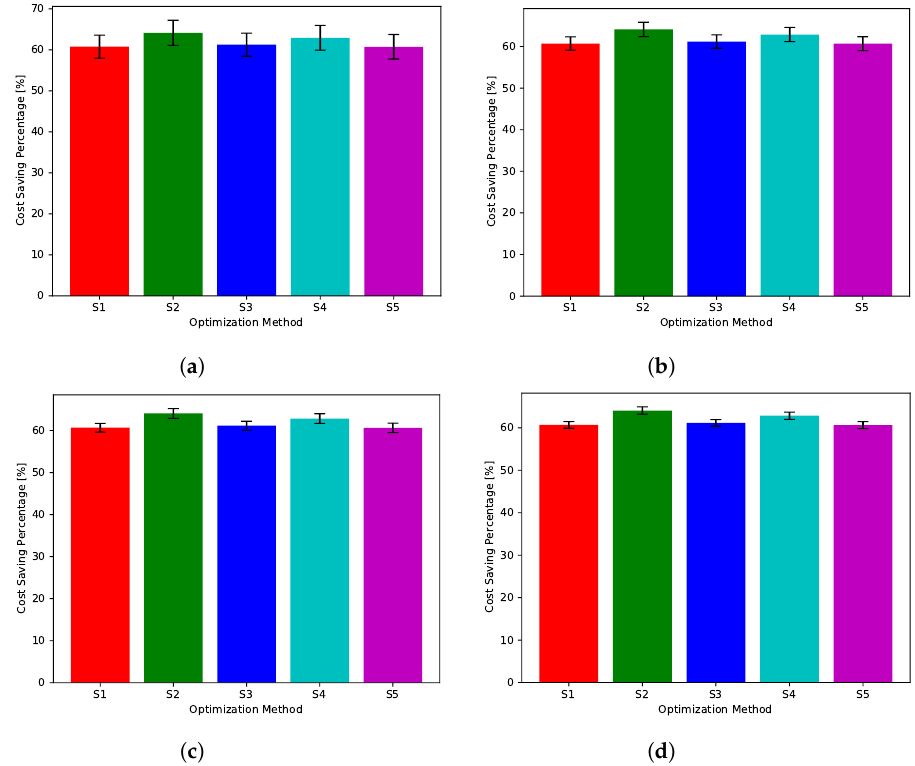
Figure 25. The total cost saving achieved by the proposed greedy scheduler when compared with scheduling policies fixed uncertainty level U 50 . ( a ) Monthly, ( b ) quarterly, ( c ) semiannually, and ( d )